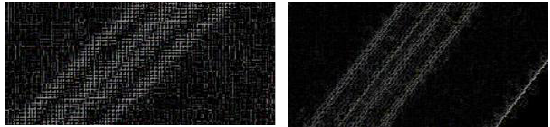
Figure 12. Images from Figure 8 after using Laplace'a filter The big problem of UAV technology is that of the lack of coverage. During the flight due to high winds there may occur gaps in coverage, what can be shown on the orthophoto (Fig. 13).